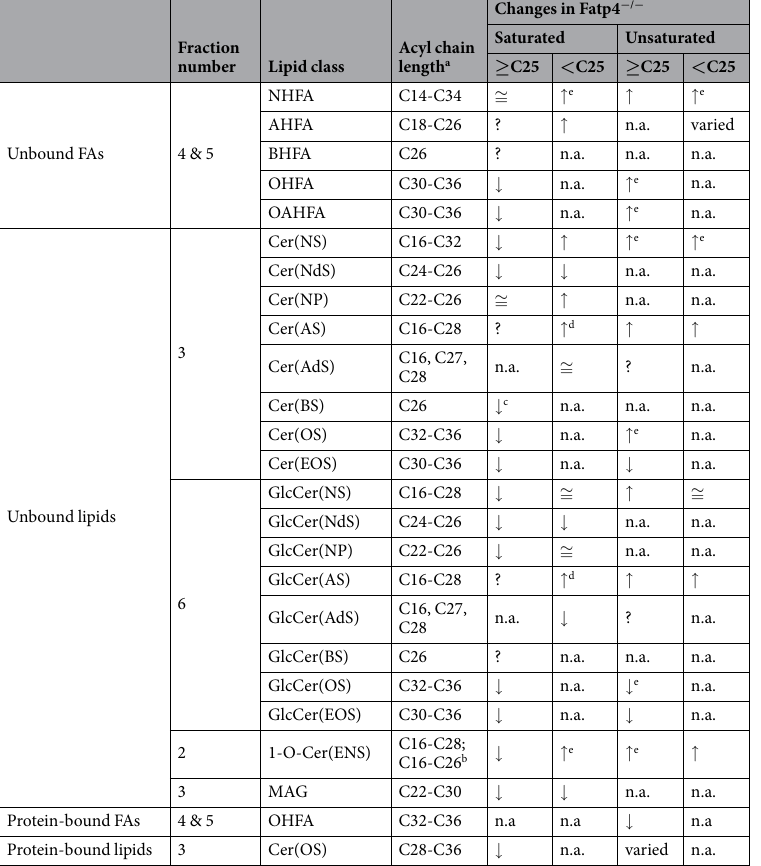
Table 1. Summarized alterations in fatty acyl chain length and saturation in unbound and protein-bound epidermal lipids in Fatp4 − / − mice. Fractionated unbound and protein-bound epidermal lipids of newborn mice were analyzed by ESI-MS and quantified as described in Materials and Methods. Changes in lipid abundance in Fatp4 − / − mice compared to controls were summarized in 4 categories based on the chain length ( ≥ C25 or < C25) and saturation (saturated or unsaturated) of the fatty acyl chains. 1-O-Cer(ENS) species that carry two saturated acyl chains are categorized as saturated whereas those that carry one or two unsaturated acyl chains are categorized as unsaturated. a amide-linked acyl chain or acyl backbone; b 1-O-linked acyl chain; c assessed by TLC; d not for C16; e not for all species; ↑ and ↓ , abundance significantly increased or decreased, respectively, compared to controls; ≅ , abundance unchanged compared to controls; ?, abundance unknown; n.a., non-